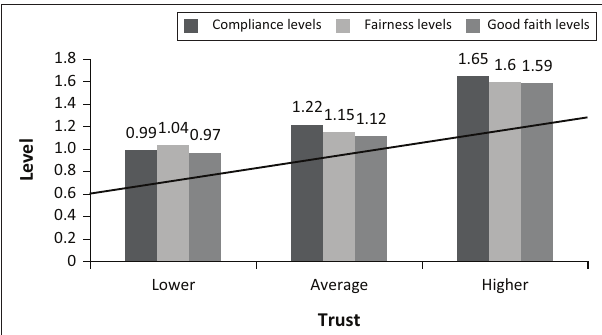
FIGURE 1: Levels of compliance, fairness and good faith at different trust levels in primary labour